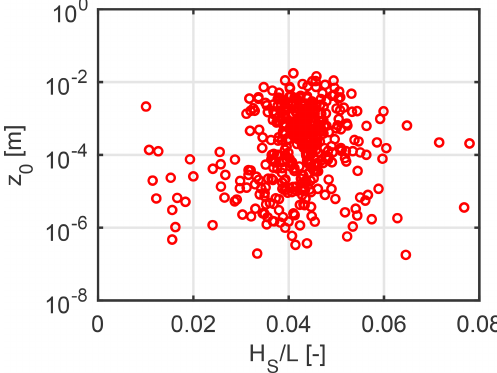
Roughness length as a function of wave steepness.